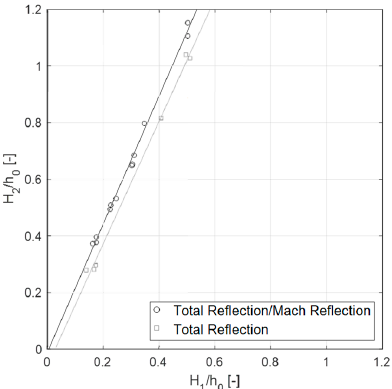
Figure 9. Ratio of wave height after reflection and initial water level in dependence of the ratio of initial wave height and initial water level for the case of total reflection and total reflection combined with Mach reflection.